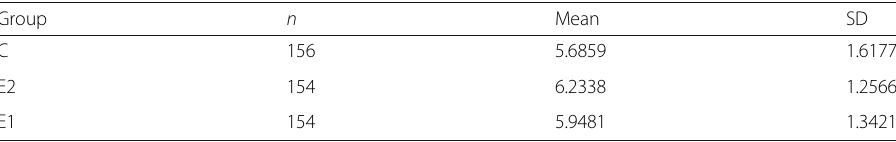
Table 14 The combined mean for Material 2 Group